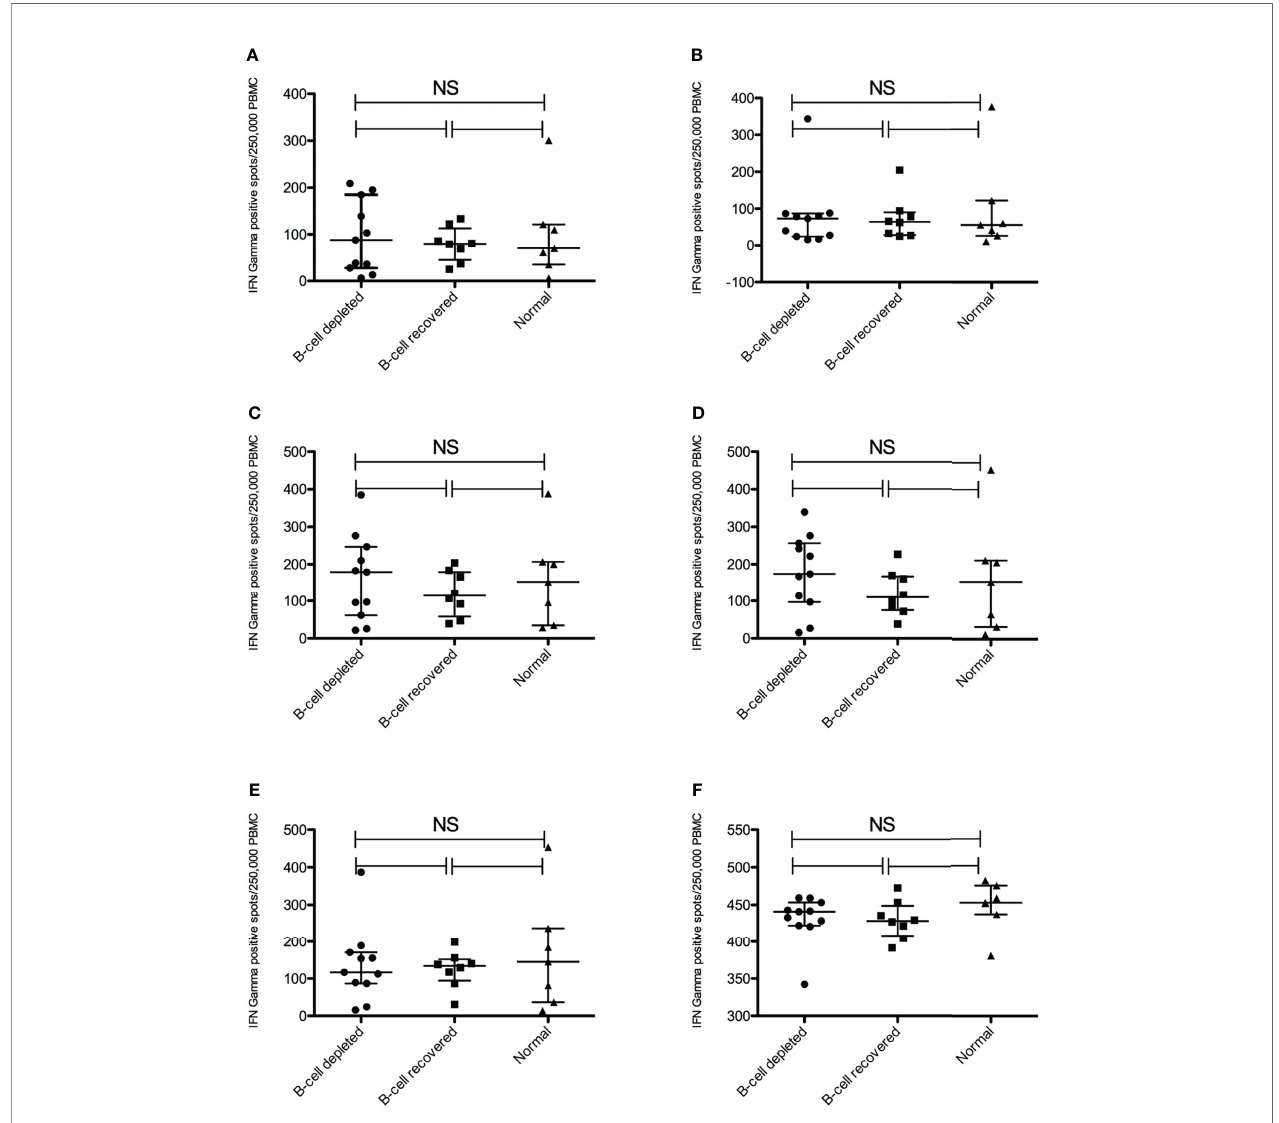
FIGURE 2 | Anti-SARS-CoV-2 Spike T-cell responses measured by IFN g ELISPOT positive spots using different antigens. (A) S1 subunit SARS-COV-2 spike glycoprotein (B) S2 subunit SARS-COV-2 SPIKE, (C) SARS-COV-2 SPIKE peptide pool (JPT v1-158P), (D) SARS-COV-2 spike peptide pool (JPT v2-157P), (E) SARS-COV-2 spike RBD peptide pool and (F) Tetanus Toxoid. NS, not signi fi